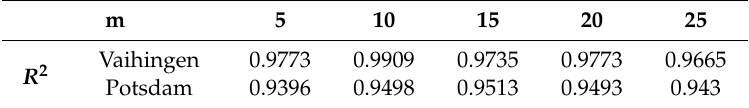
Table 5. Relationship between parameter m and the square of correlation coe ffi cient ( R 2